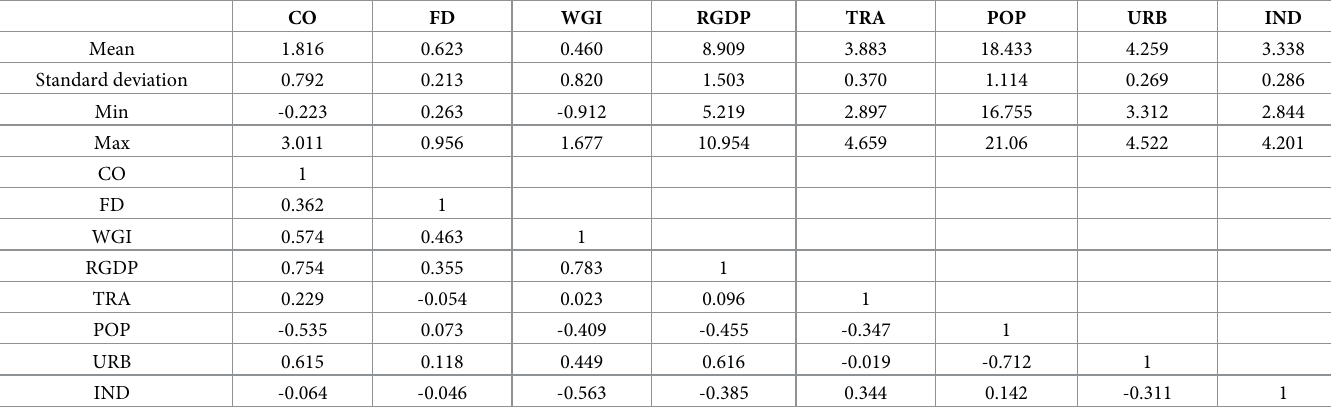
Table 2. Summary statistics and